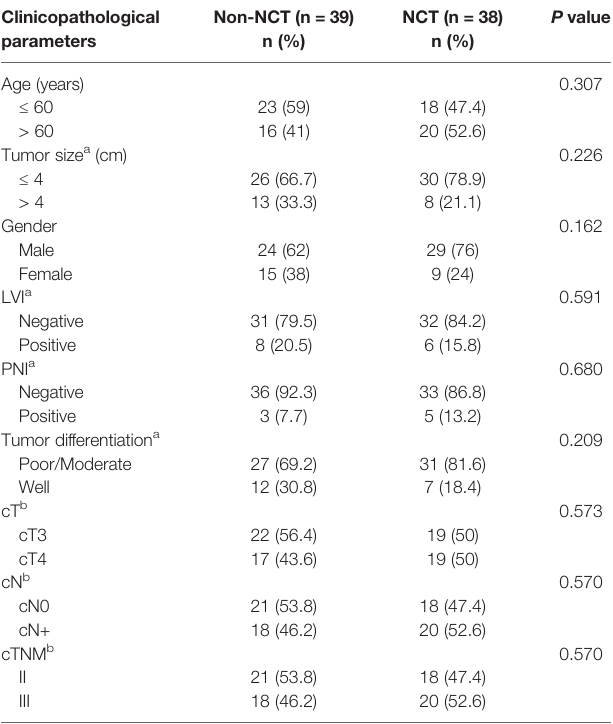
TABLE 1 | Characteristics of pMMR CRC patients who received neoadjuvant chemotherapy (NCT) or did not receive NCT (non-NCT) (n = 77). Clinicopathological